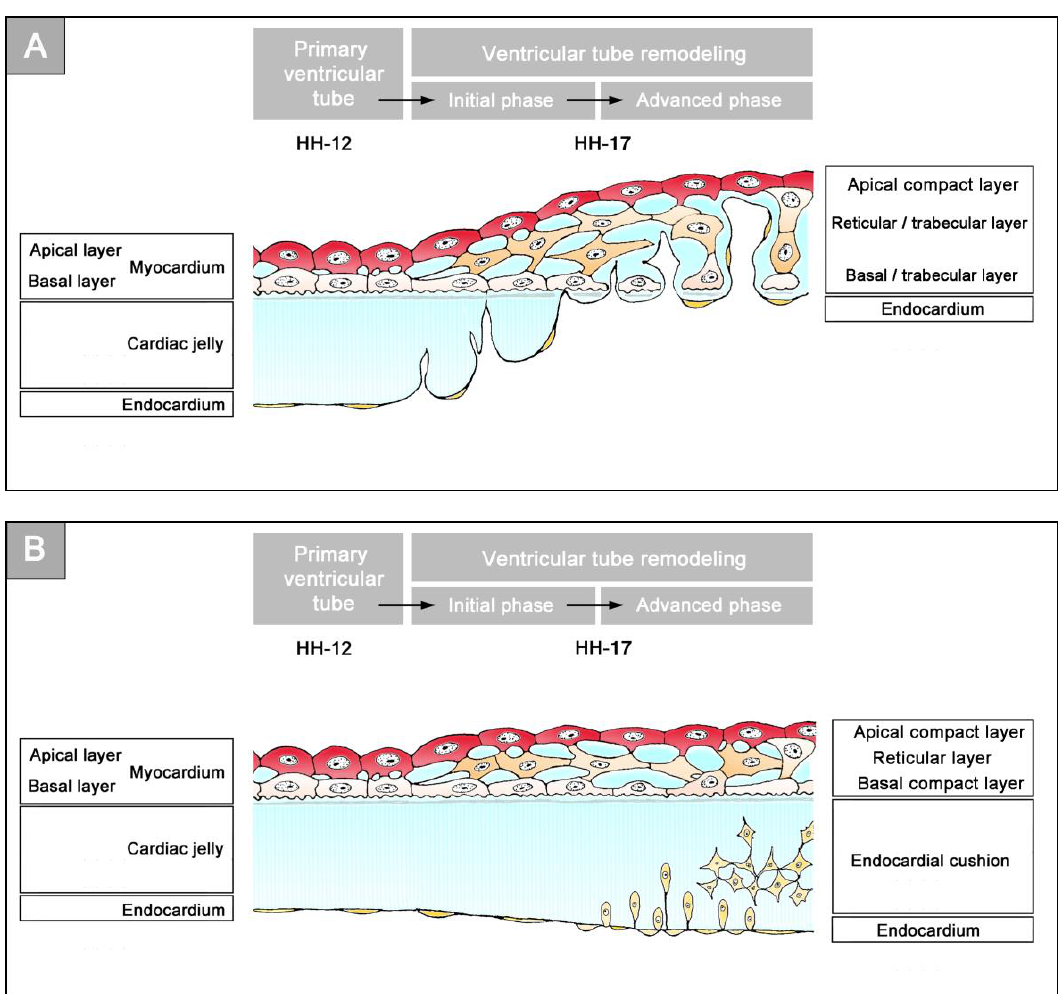
Figure 5. These schematic drawings illustrate the region-specific remodeling of the primary ventricular tube of higher vertebrate embryos as seen in the chick (based on data from Manasek [56] and Icardo and Fernandez-Terán [57]). ( A ) Remodeling along the outer curvature of the ventricular bend. CJ disappears due to the outgrowth of multiple endocardial pouches from the endocardial tube (initial phase of remodeling). When the endocardial pouches reach the basal layer of the myocardium, they start an invasion of the myocardial wall. Now, remodeling is no longer confined to the endocardium and CJ, but, additionally, changes the wall architecture of the myocardial tube. The initially smooth inner myocardial wall becomes transformed into a trabeculated myocardial wall (advanced phase of remodeling). ( B ) Remodeling in the inflow and outflow portions of the ventricular tube. CJ does not disappear, but loses its cell-free phenotype due to the invasion of endocardium-derived mesenchymal cells. Cellularized CJ is named endocardial cushions (in the inflow portion) or endocardial ridges (in the outflow portion).